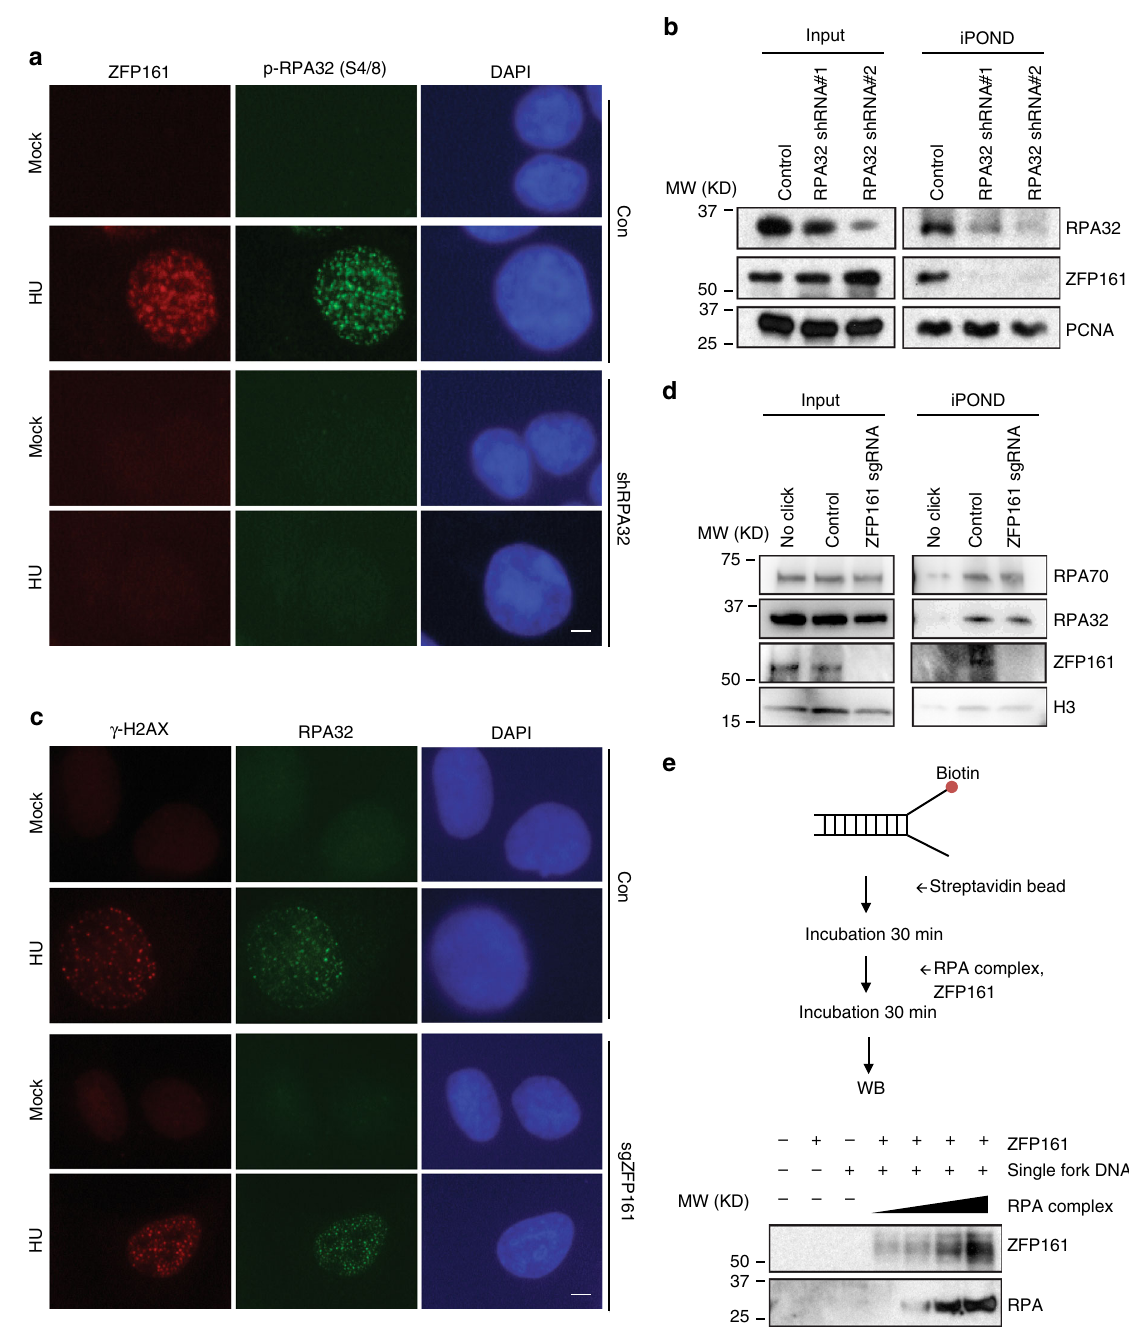
Fig. 2 ZFP161 is enriched at replication forks. a Cells were depleted of RPA32 using shRNA. The co-localization of phospho-RPA32 (S4/S8) and ZFP161 were determined by immuno fl uorescence. b RPA32 de fi cient HCT116 cells were incubated with EdU and HU. Replication fork proteins were isolated by iPOND and immunoblotted with indicated antibodies. c Cells were depleted of ZFP161 using sgRNA. The co-localization of RPA32 and γ H2AX were determined by immuno fl uorescence. d ZFP161 de fi cient HCT116 cells were incubated with EdU and HU. Replication fork proteins were isolated by iPOND and immunoblotted with indicated antibodies. e Puri fi ed GST-ZFP161 protein and RPA complex were incubated with biotin labeled single fork DNA. The proteins retained on DNA were determined by immunoblotting. Scale bars, 10 µ m. Source data are provided as a Source Data fi